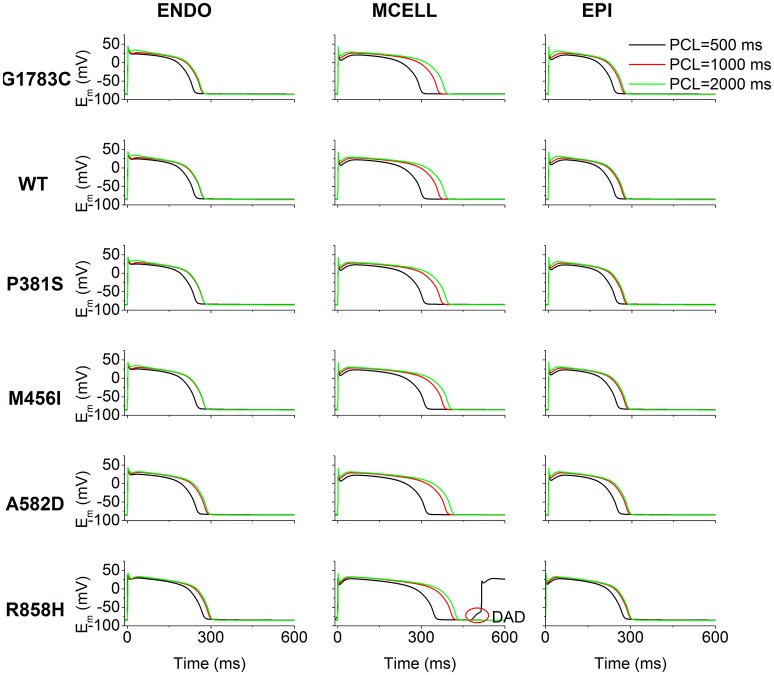
Simulated action potentials (Em) for the Ten Tusscher-Panfilov (TP06) human ventricular cell model at different pacing cycle lengths (PCL) under G1783C, wild-type (WT), P381S, M456I, A582D, and R858H conditions. Endocardial (ENDO, left column), midmyocardial (MCELL, middle column) and epicardial (EPI, right column) action potentials at the PCL of 500 (Black), 1,000 (Red), and 2,000 ms (Green), respectively. Action potential duration abbreviates with a decrease in PCL. For each mutation, action potential duration of MCELL cells is longer than that of other cells. Among in these mutations, when the PCL is 500 ms for R858H, delayed afterdepolarizations (DAD, marked with a red circle) were triggered in MCELL cells.